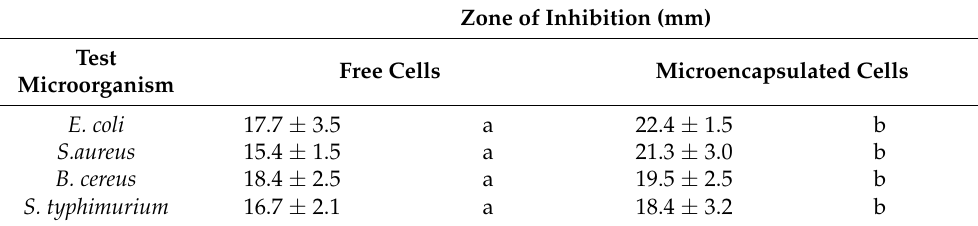
Table 7. Antimicrobial activity of the free cells and microencapsulated cells (alginate+xanthan gum) of L. rhamnosus